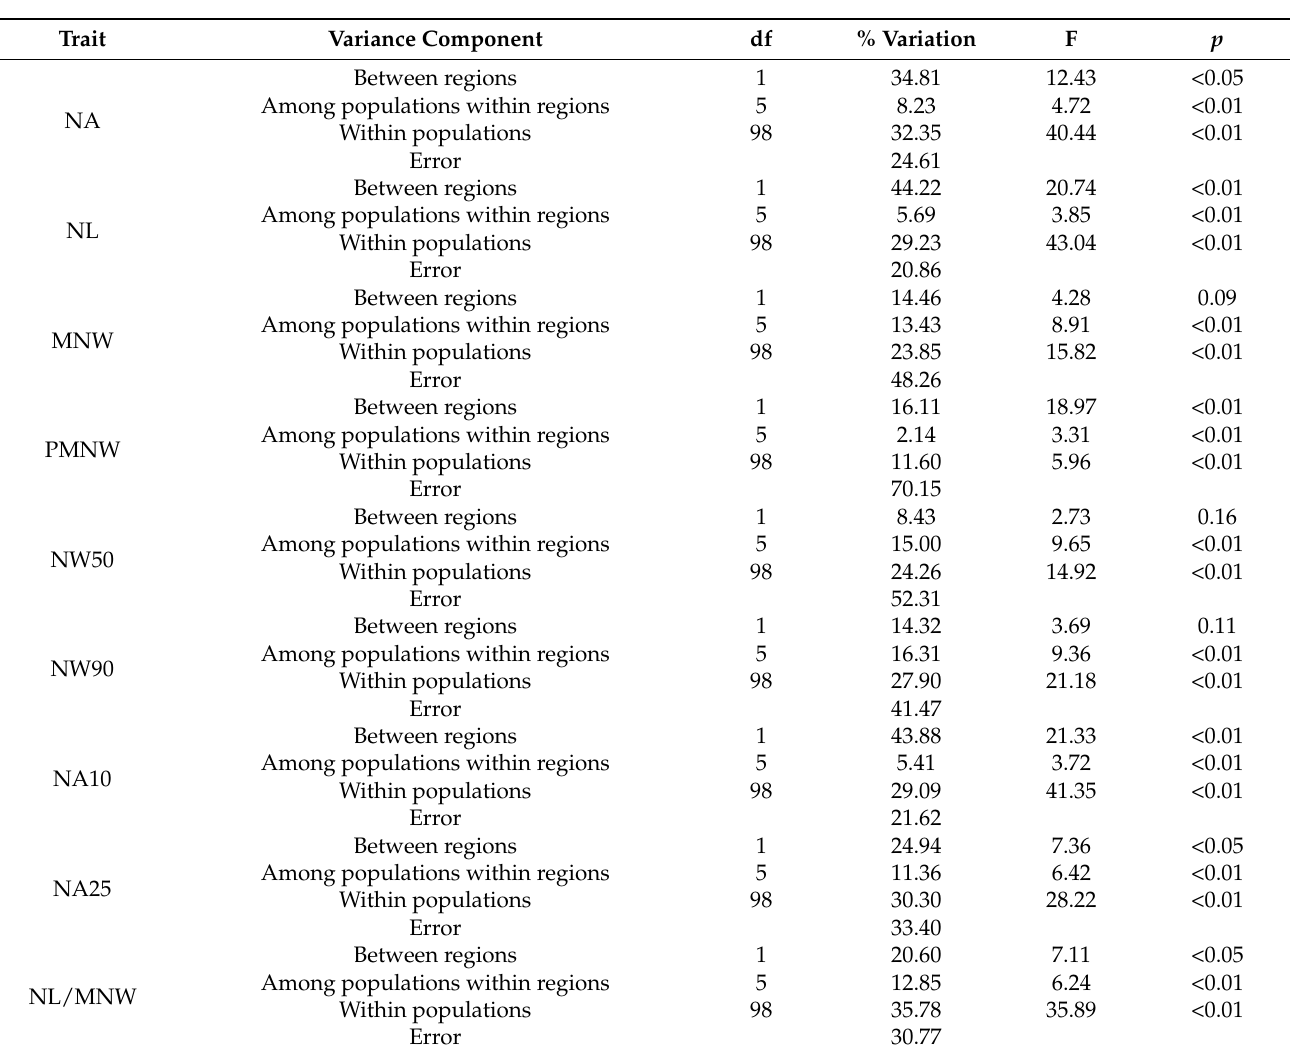
Table 2. Results of the hierarchical analysis of variance. Morphometric traits analysed: needle area (NA); needle length measured from the base of the needle up to the tip, along the central vein (NL); maximum needle width (MNW); needle length, measured from base to the widest point of needle (PMNW); needle width at 50% (NW50) and 90% (NW90) of needle length; angle enclosed by the main vein and line between needle base and point on the 10% (NA10) and 25% (NA25) of needle length; for needle shape, needle length/maximum needle width ratio